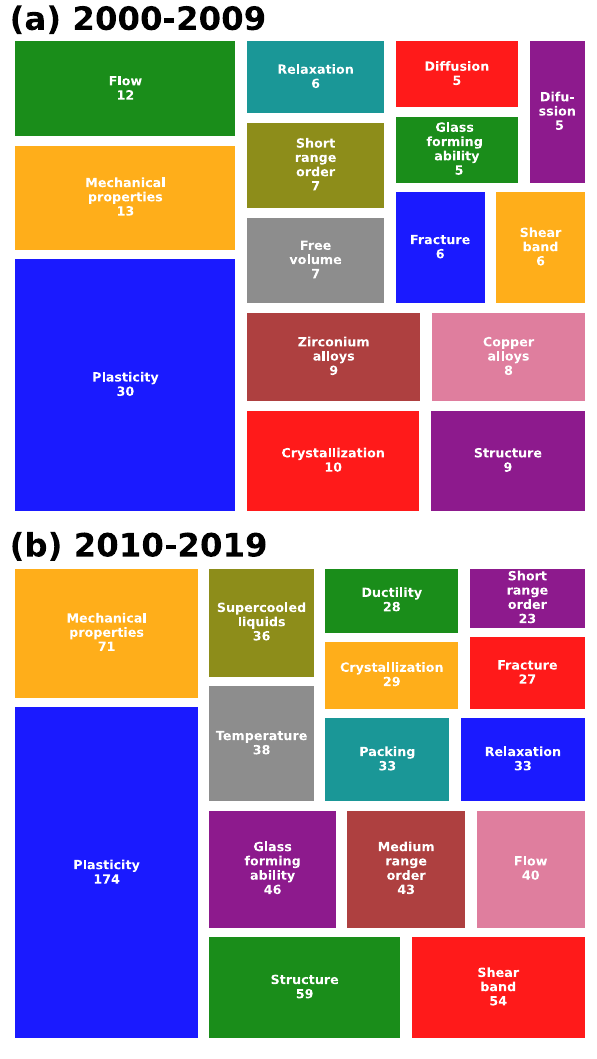
Fig. 8 Most common keywords a from 2000 to 2009 and b from 2010 to 2019